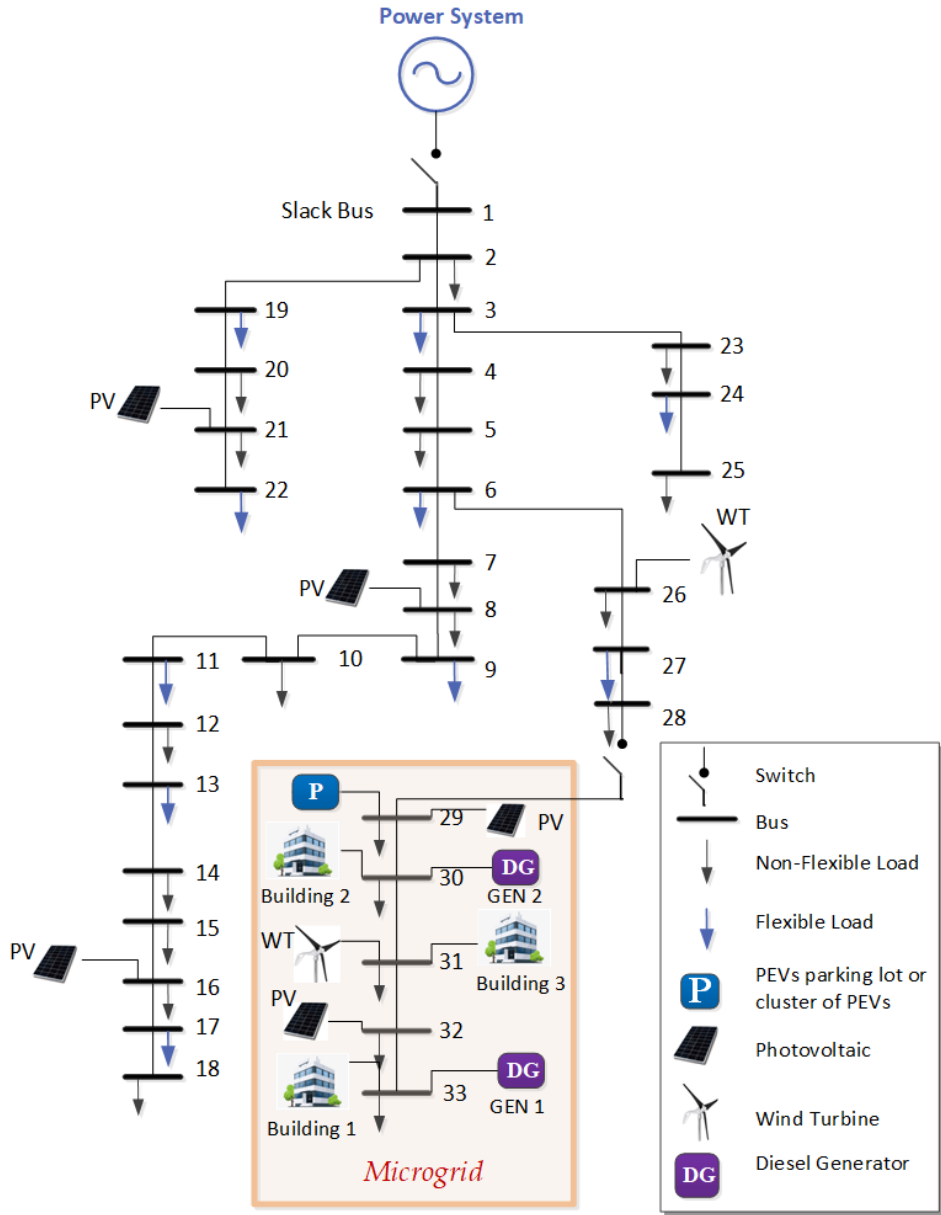
Figure 3. Single ‐ line diagram of the examined distribution network. Figure 3. Single-line diagram of the examined distribution